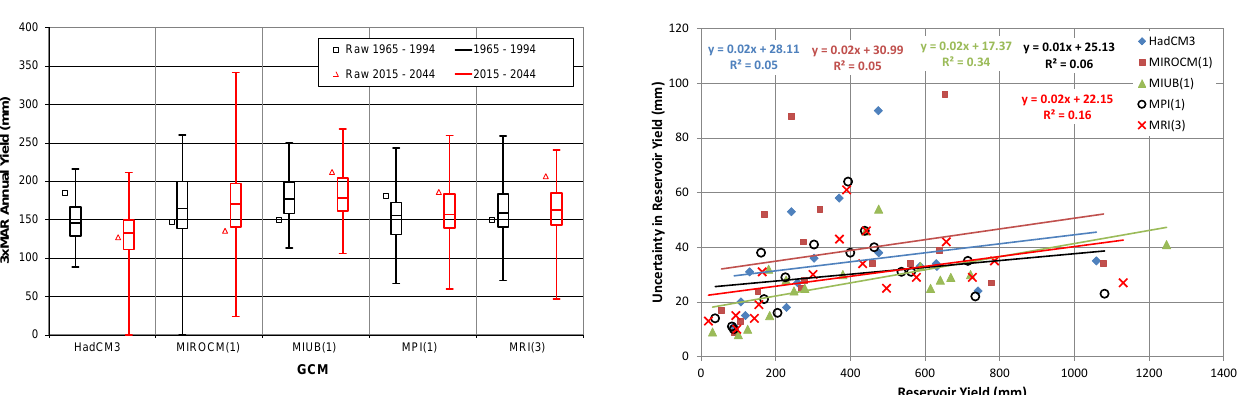
Figure 13. Within-GCM uncertainty (mmyr − 1 ) in reservoir yield versus reservoir yield based on 100 Gould–Dincer Gamma esti- mates (hypothetical capacity: τ = 3, reliability of draft: 95%) from PERM runs of monthly precipitation and temperature replicates (2015–2044, A1B) from five